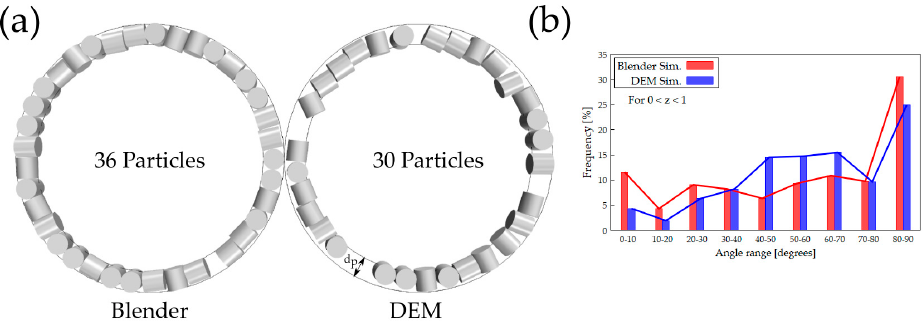
Figure 9. ( a ) One layer of cylinders touching the container wall. ( b ) Orientation distribution of near-wall cylinders.